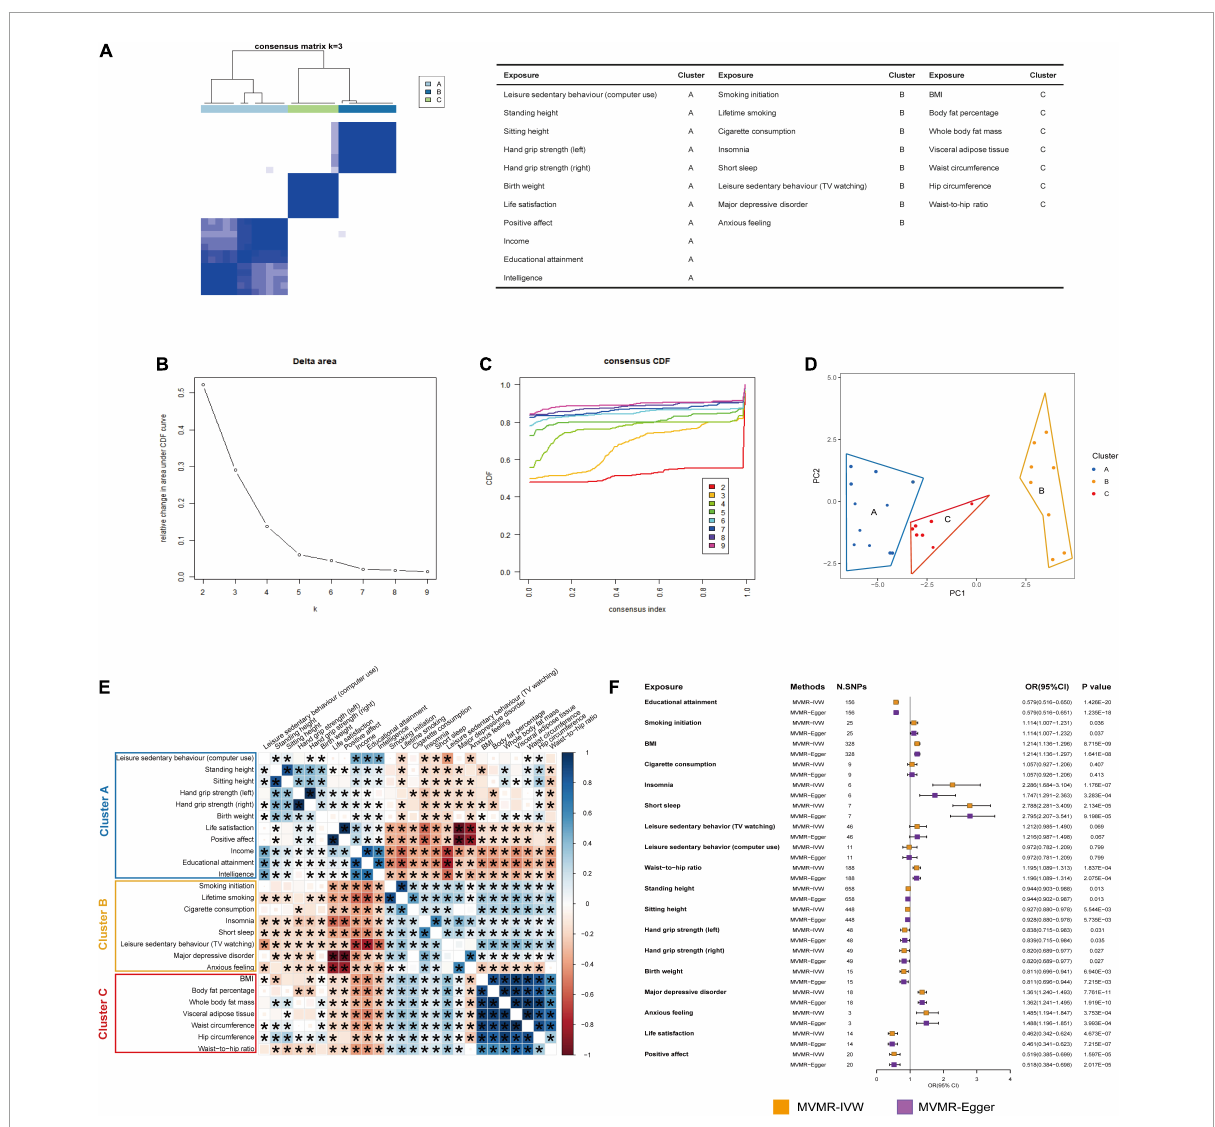
FIGURE5 PAM clustering and MVMR analyses. (A) The PAM clustering matrix heatmap when K = 3. (B) The change of slope of CDF curve in PAM clustering for 26 exposures. (C) The change of area under CDF curve in PAM clustering for 26 exposures. (D) Principal component analysis (PCA) for 26 exposures in cluster A, cluster B, and cluster C. (E) Genetic correlations between 26 exposures. The size and color of squares respectively represented the significance level and genetic correlation directions. Genetic correlations with P ≤ 0.05 would be showed with asterisks. (F) The forest plot showed the results of the causal associations between 15 exposures and the risk of GORD after MVMR analyses with adjustment of educational attainment, smoking initiation, or BMI. The causal effects were represented as ORs with MVMR-IVW method (orange box) and MVMR-Egger method (purple box). The MVMR results estimated with MVMR-IVW method and MVMR-Egger method were summarized in Supplementary Table 7 in